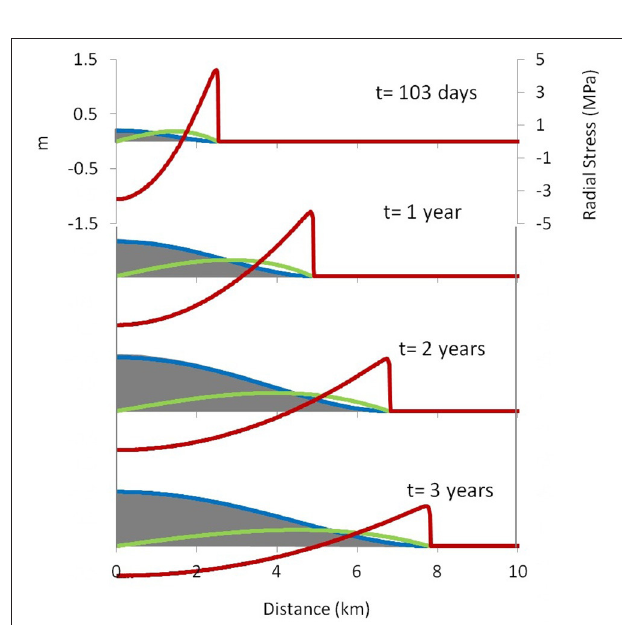
FIGURE 8 | The sill thickness and stress at the bottom of the elastic plate obtained in the REF case simulation ( Table 1 ; Figure 3 ). On the horizontal axis, the distance from the point of magma injection (km). The uplift (blue line) and the radial displacement (green line) at four different times (103 days, 1 year, 2 years, and 3 years) are shown (meters; left axis). The red lines represent the radial stress (MPa, right axis) at the base of the elastic plate (negative values for compression and positive values for